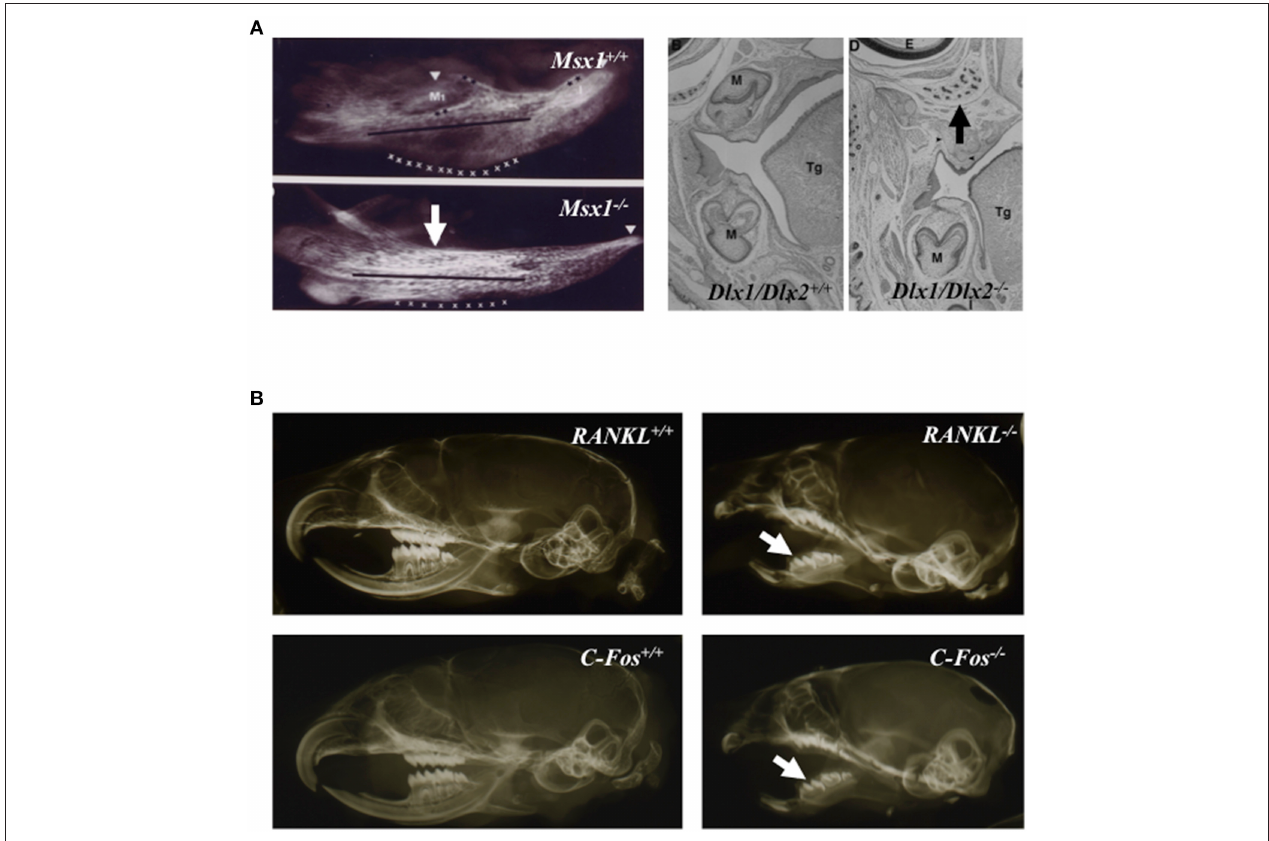
FIGURE 2 | Tooth agenesis consequence on alveolar bone formation (A) and close to normal crown morphology in osteopetrotic animals (B). Mandible micro-radiographies and head frontal sections of newborn Msx1 and Dlx1/Dlx2 null mutants (A) ; Msx1 null mutant mouse image taken form Orestes-Cardoso et al. (2002) . Absence of alveolar bone formation in area of tooth agenesis (arrows). Micro-radiographies of wild type, C-Fos − / − and RANKl − / − 21 day-old mouse heads (B) the formation of dental crowns (arrows) in osteopetrotic mutant mice with morphologies close to those of control littermate mice. M, molar; Tg, tongue.